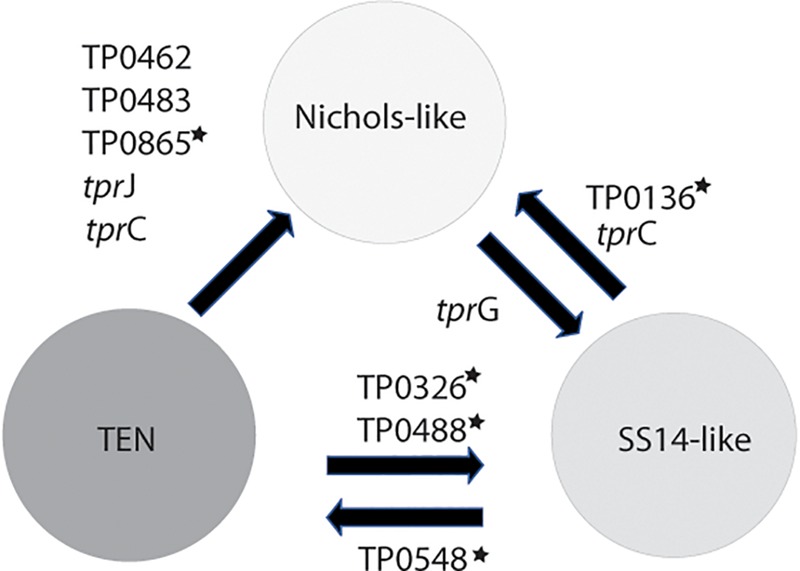
Inter-clade recombinations identified to date. The genes with stars represent loci, which were previously identified as recombinant (Pětrošová et al., 2012; Arora et al., 2016; Mikalová et al., 2017b; Grillová et al., 2018c). Five (out of 10) loci were identified in this study and were found among contemporary clinical samples enriched by a sequence-independent enrichment method.